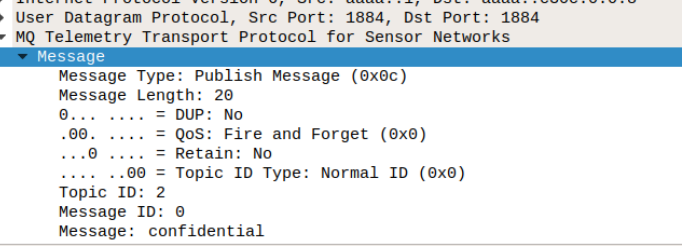
Figure 9. Malicious mote subscribed to confidential